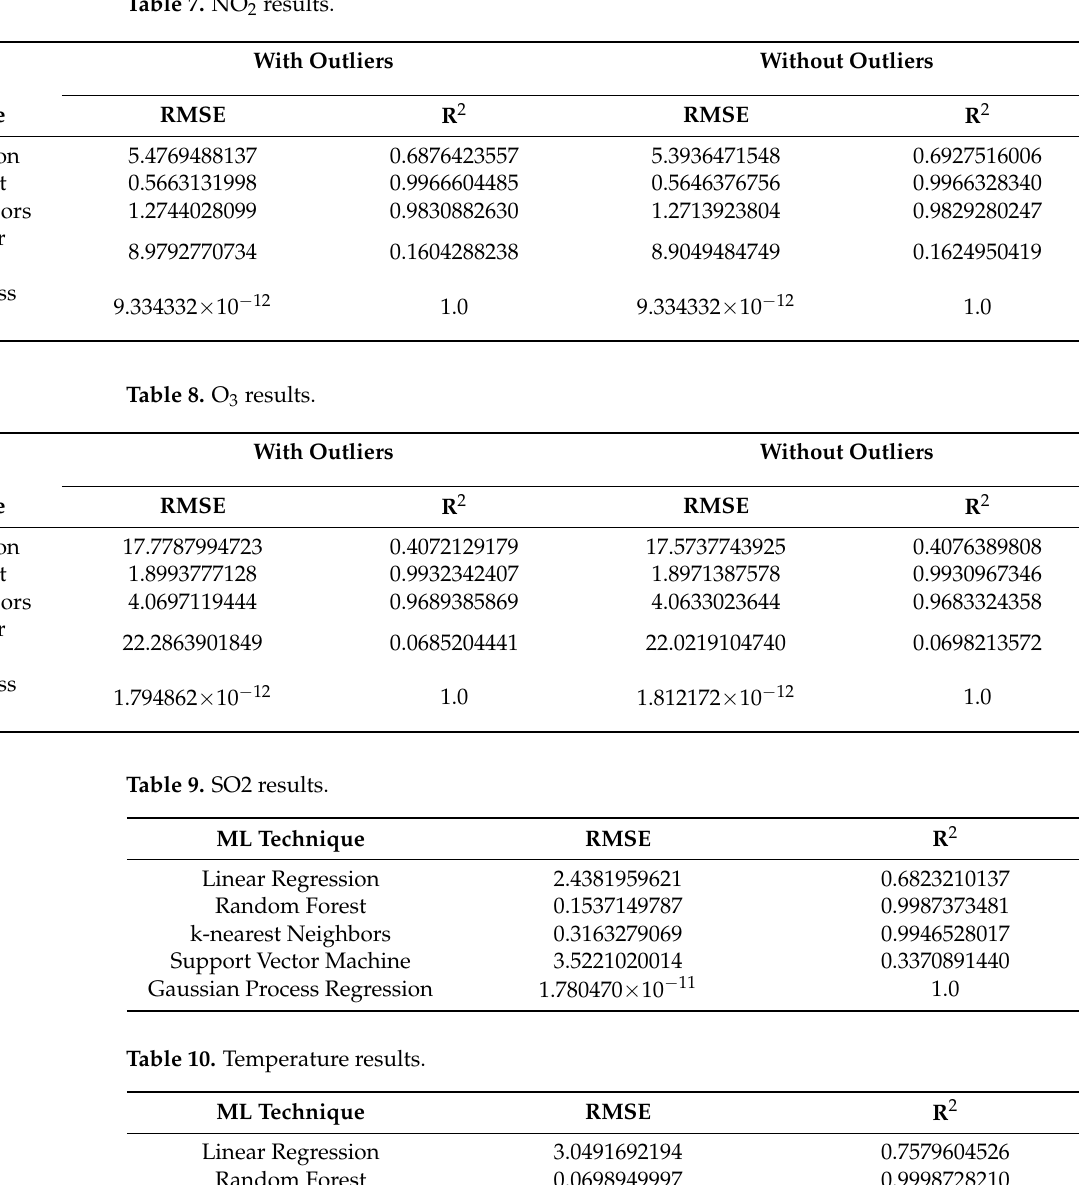
Table 7. NO 2 results.